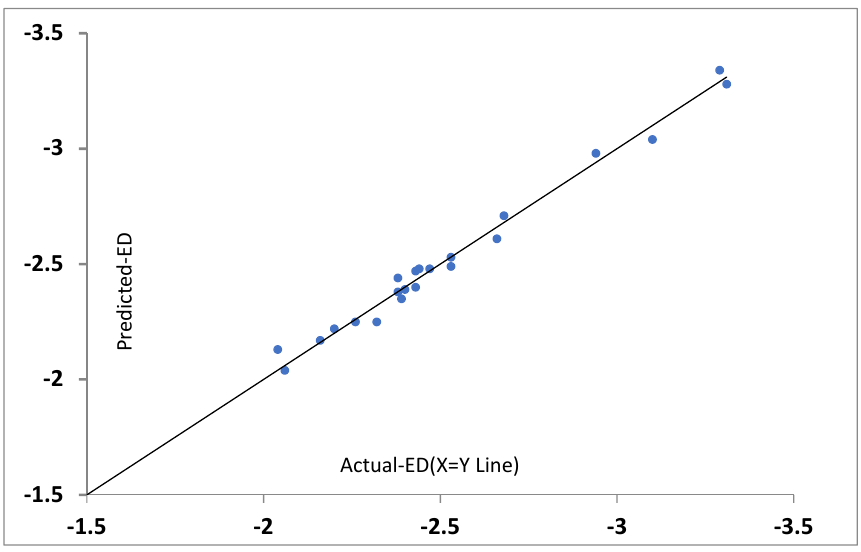
Figure 1. Predicted ED values of CoMFA model vs experimental ED value. The electrostatic and steric contribution maps of CoMFA are shown in Figure 2. The contribution rate of the electrostatic field and the steric field were 24.8% and 75.2%, re- spectively, revealing that the steric field was the major contributor to the increase in the antifungal activity against P. piricola . In Figure 2A, there were some green regions located around the 2-position of the benzene ring indicating that the introduction of bulky group